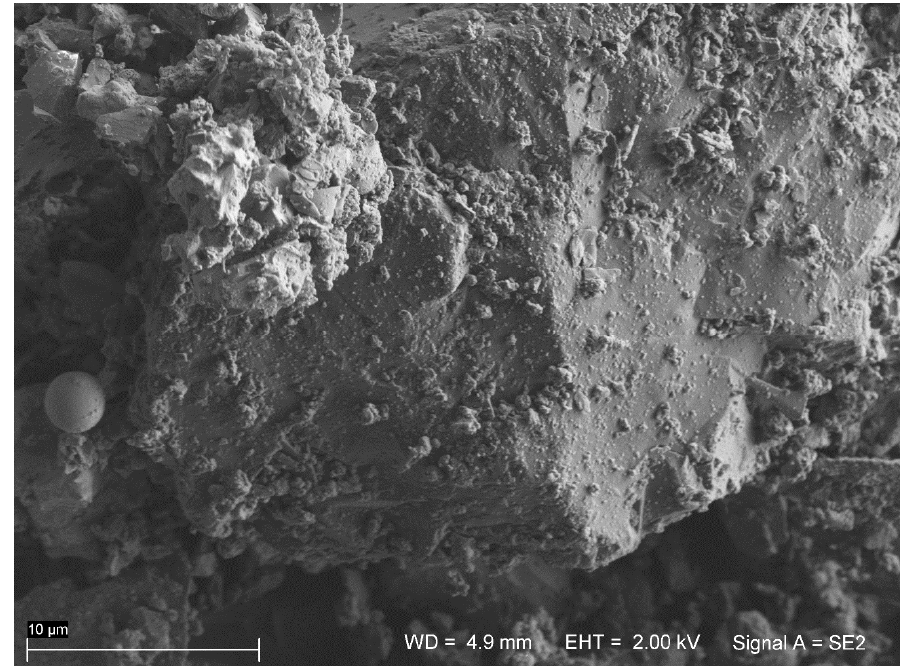
Figure 2. SEM image of the cement sample with TiO 2 distribution on the cement grain (Everhart–Thornley type detector at ETH = 2.0 kV).